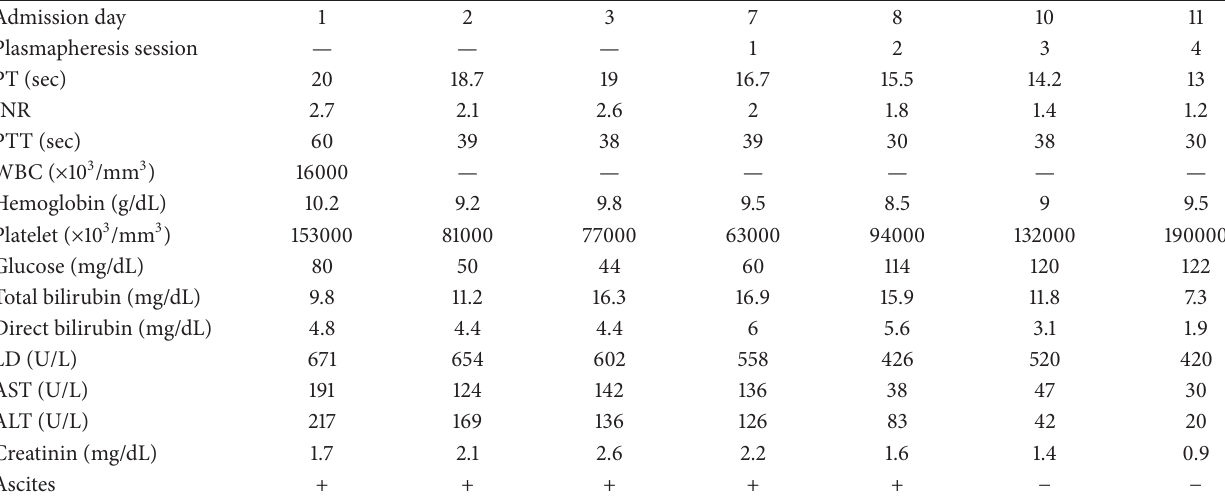
Table 2: Laboratory data of the second